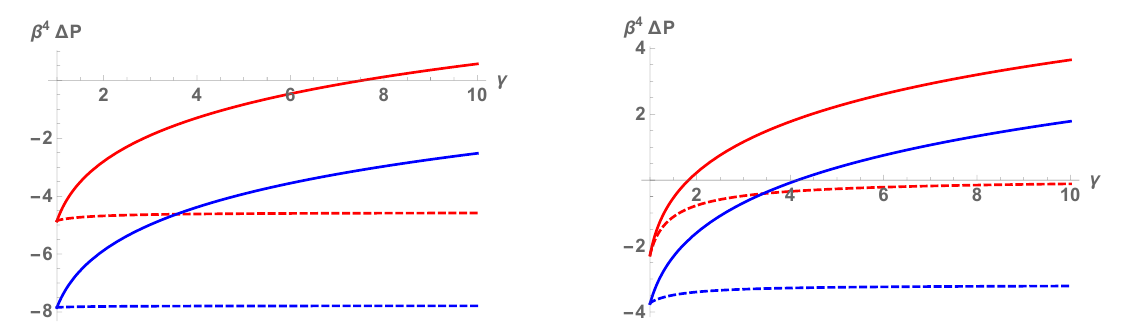
Figure 9 . Natural logarithm of the force on the bubble ∆ P z given by the ballistic approxima- tion (3.39) and the lte approach (3.41) as a function of the Lorentz factor γ . Left panel: m = 0 . 1 T (lte: solid blue; ballistic: dashed blue), m = 0 . 5 T (lte: solid red; ballistic: dashed red). Right panel: m = 1 T (lte: solid blue; ballistic: dashed blue), m = 5 T (lte: solid red; ballistic: dashed